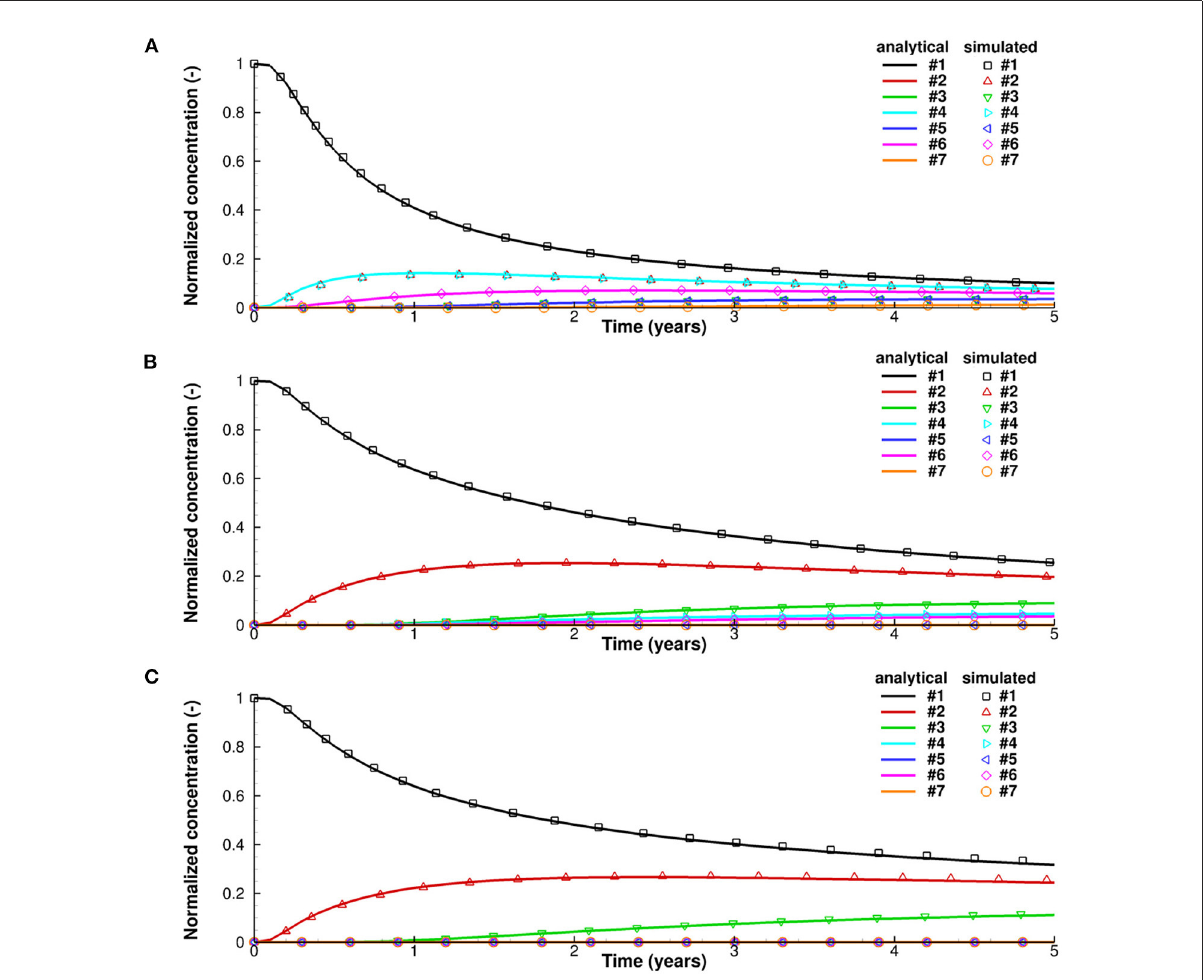
FIGURE2 Normalized concentration change over time at specified observation points for 2D anisotropic diffusion verification problem, (A) with anisotropy ratio τ ′ xx : τ ′ yy = 1 : 1, (B) with anisotropy ratio τ ′ xx : τ ′ yy = 10 : 1, and (C) with anisotropy ratio τ ′ xx : τ ′ yy = 100 :